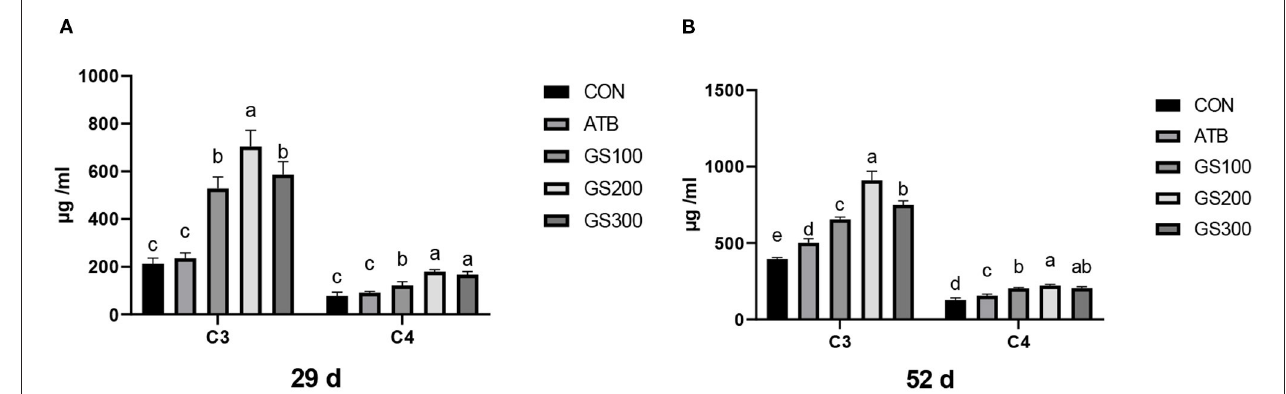
FIGURE 9 | Effects of ginsenoside Rg1 on serum complement C3 and C4 at day 29 (A) and day 52 (B) in broiler chickens ( n = 6). CON, birds fed a basal diet; GS100, birds fed a basal diet supplemented with 100 mg/kg ginsenoside Rg1; GS200, birds fed a basal diet supplemented with 200 mg/kg ginsenoside Rg1;